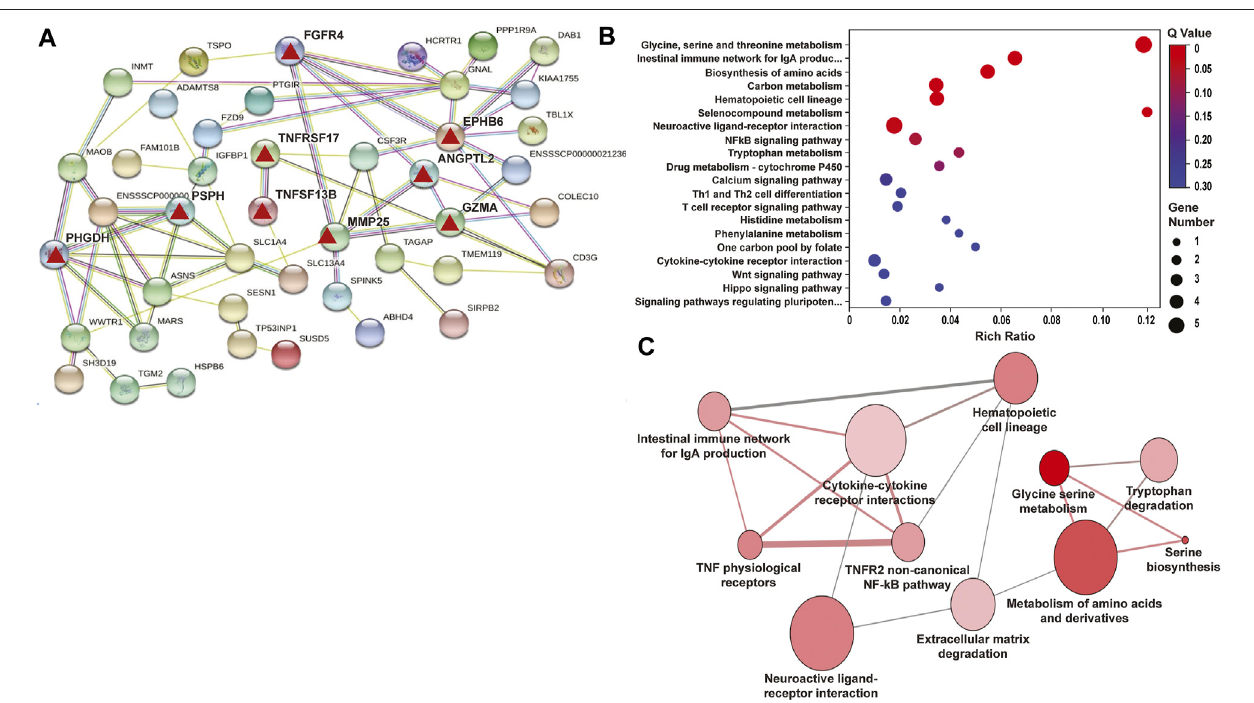
FIGURE 7 | Differentially-expressed genes (DEGs)/pathways in LPS/VILI-exposed porcine lung tissues: In fl uence of ALT-100 mAb on gene network interactions. RNA sequencing data of lung tissues yielded 332 differentially-expressed genes (DEGs) between control pigs and LPS/VILI-challenged pigs (12 h) ( Table 1 ) and 465 DEGsfromLPS/VILI-exposedrats( SupplementaryTableS1 ).The#ofDEGsin fl uencedbyALT-100mAbinfromLPS/VILI-challengedpigsis62( Table2 )andinratsis 34( Table3 ). (A) ShownistheSTRINGFunctionalproteinnetworkinteractionofDEGsin fl uencedbyALT-100mAbtreatmentinpigs.Theedgesrepresentprotein- protein associations, line color indicates the evidence the type of interaction (green-gene neighborhood, red-gene fusion, blue-co-occurrence, black-co-expression). The con fi dence interaction score is 0.15. Highlighted are speci fi c genes (red triangles) that are detailed in the Discussion. (B,C) Shown are the top 20 KEGG enriched pathwaysintheALT-100mAbrescuedporcinemodel.TheRichfactoristheratioofDEGsnumbersannotatedinthispathwaytermtoallgenenumbersannotatedinthis pathway term. Q value is the corrected p value, the size of the bubble corresponds to the number of genes annotated in that pathway.